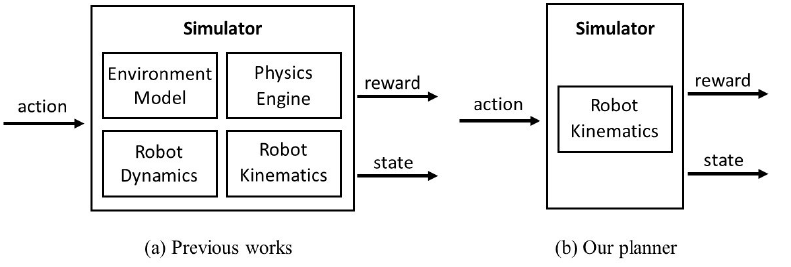
Figure 3. Schematic view of the